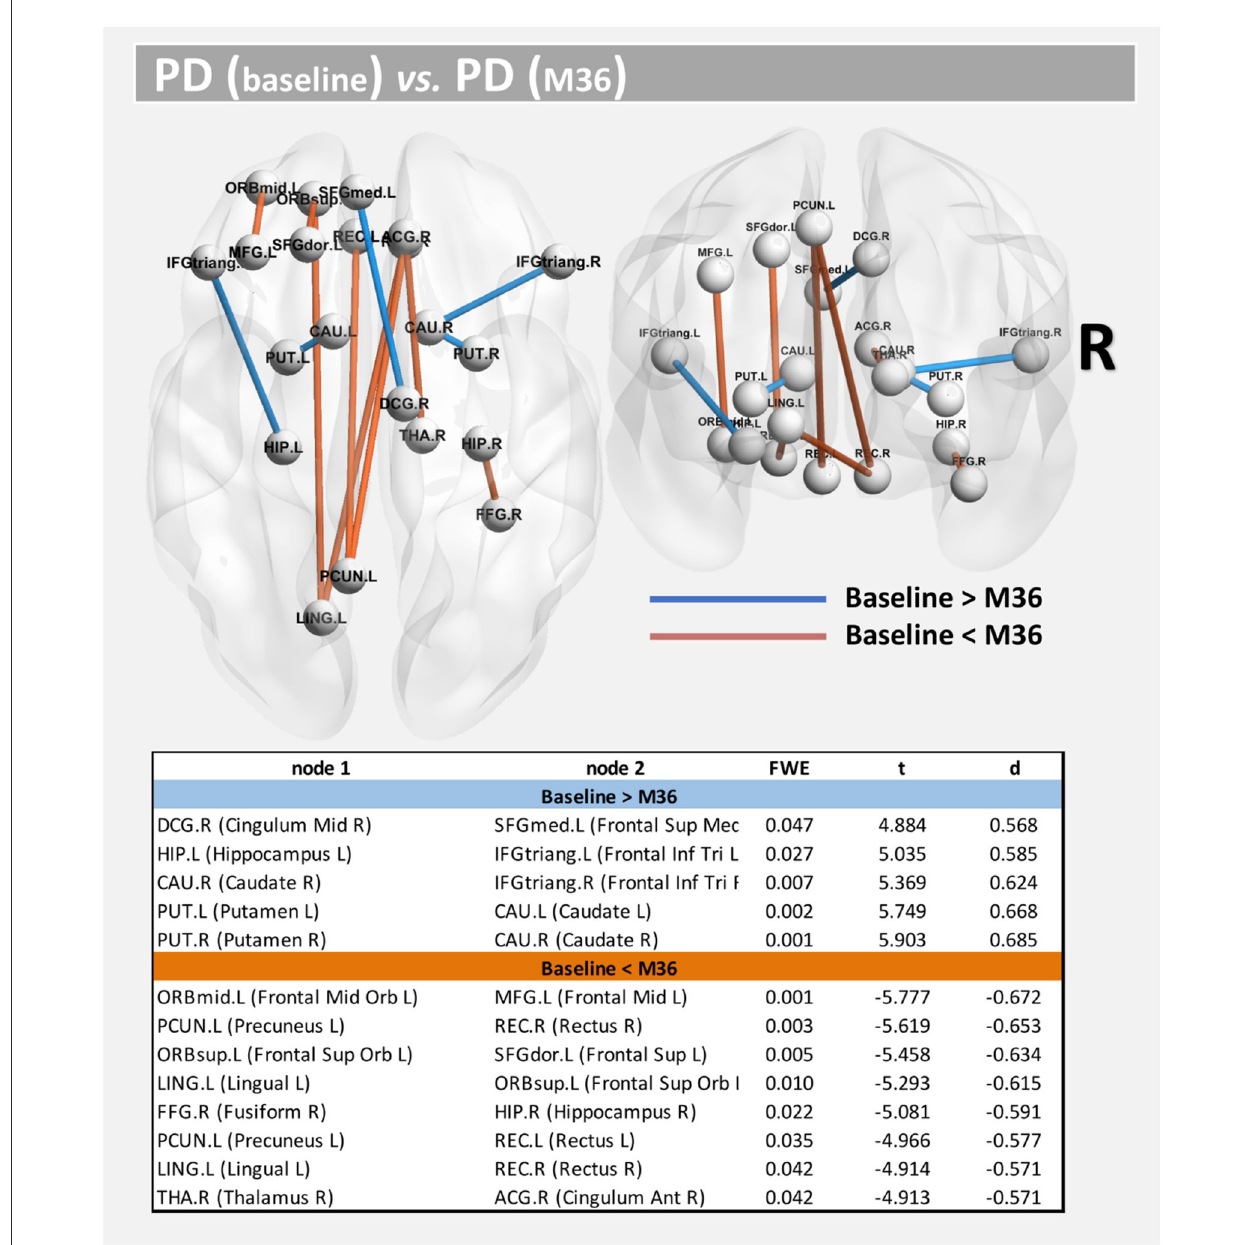
FIGURE4 Altered structural connectivity in PD between baseline and M36 (longitudinal analysis). Compared with baseline, PD subjects at M36 showed higher connectivity (red paths) and lower connectivity (blue paths) across different nodes; see also Table 3. For all significant paths we found FWE < 0.05 and medium